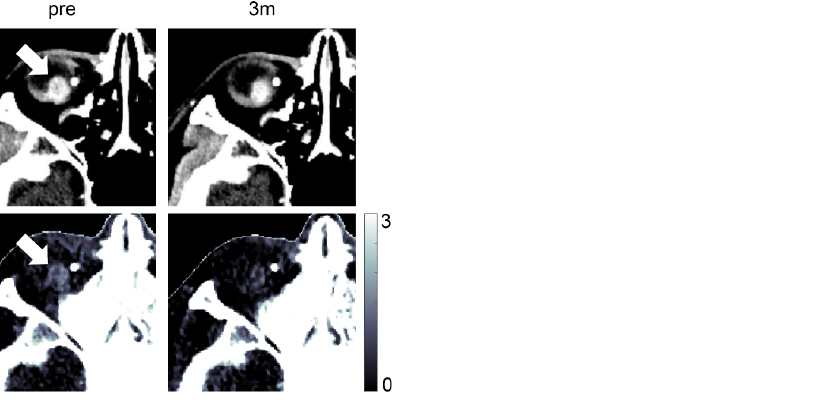
Figure 6. The contrast-enhanced CT 120 kVp and eIC_optimized map images in the representative case (pre-treatment and 3 months after treatment). The arrows indicate the tumor. Despite the favorable outcome that was judged years after, the change in the tumor cannot be judged by CT images at 3 months after treatment (the density of the tumor seems even elevating at 3 months in this specific case). On the other hand, the eIC_optimized map shows an obvious decrease in the estimated iodine concentration at 3 months compared to pre-treatment. The bony areas and the metallic marker (white dot at the left of the tumor) are shown in white color in the eIC_optimized images. The iodine concentration in these areas, which must be zero or very small, cannot be estimated correctly because eIC_optimized is specialized for calculating iodine concentration in a